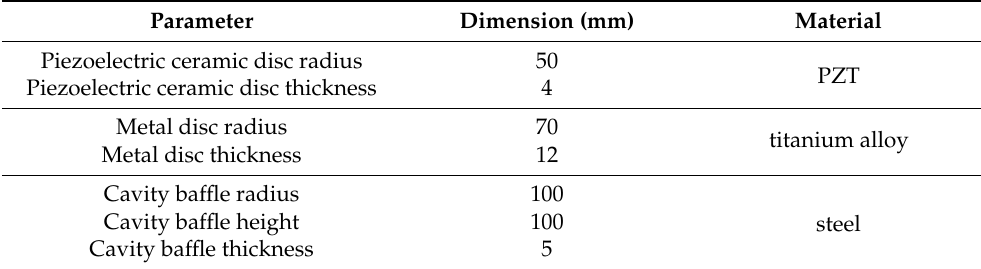
Table 1. Structural parameters of the